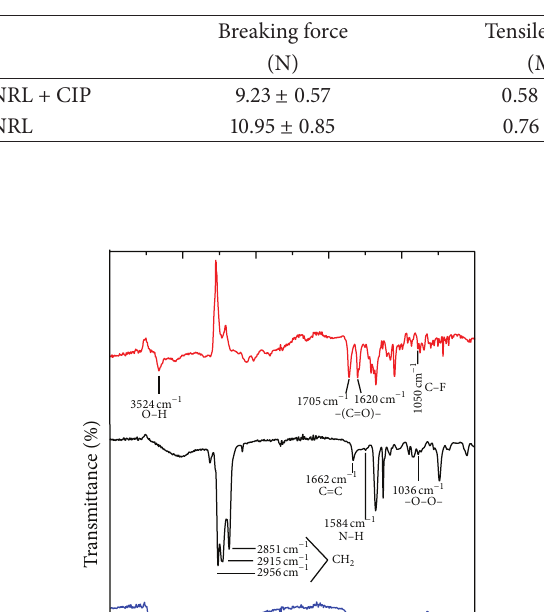
Table 2: Mechanical properties.